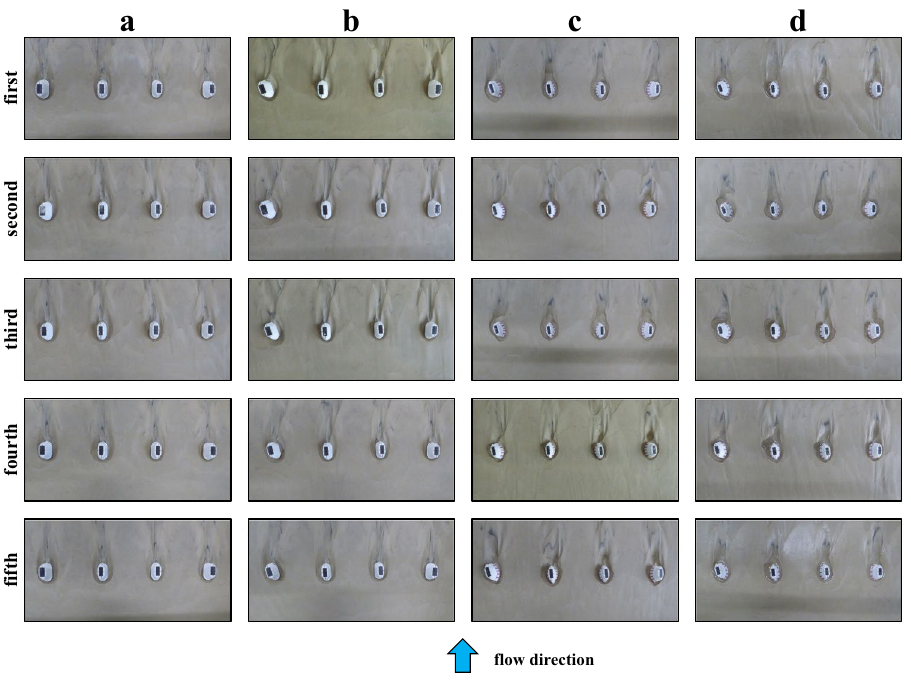
Figure 9. Photographs of sand layer and scour at end of experiment. ( a ) current; ( b ) current (skewed); ( c ) old (spindle type); ( d ) old (current